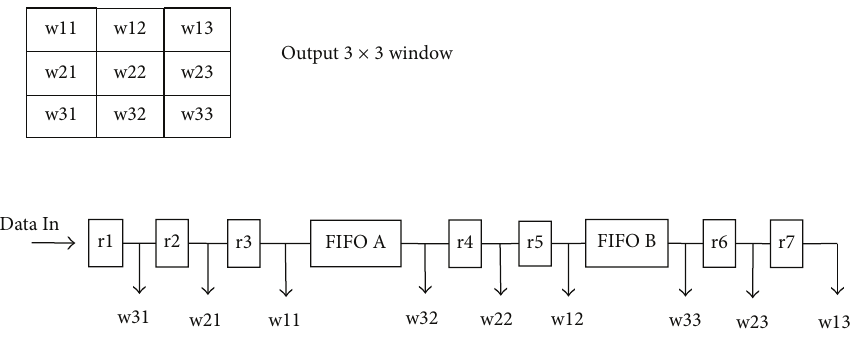
Figure 14: Data flow architecture of the window kernel implemented using the FIFO architecture.